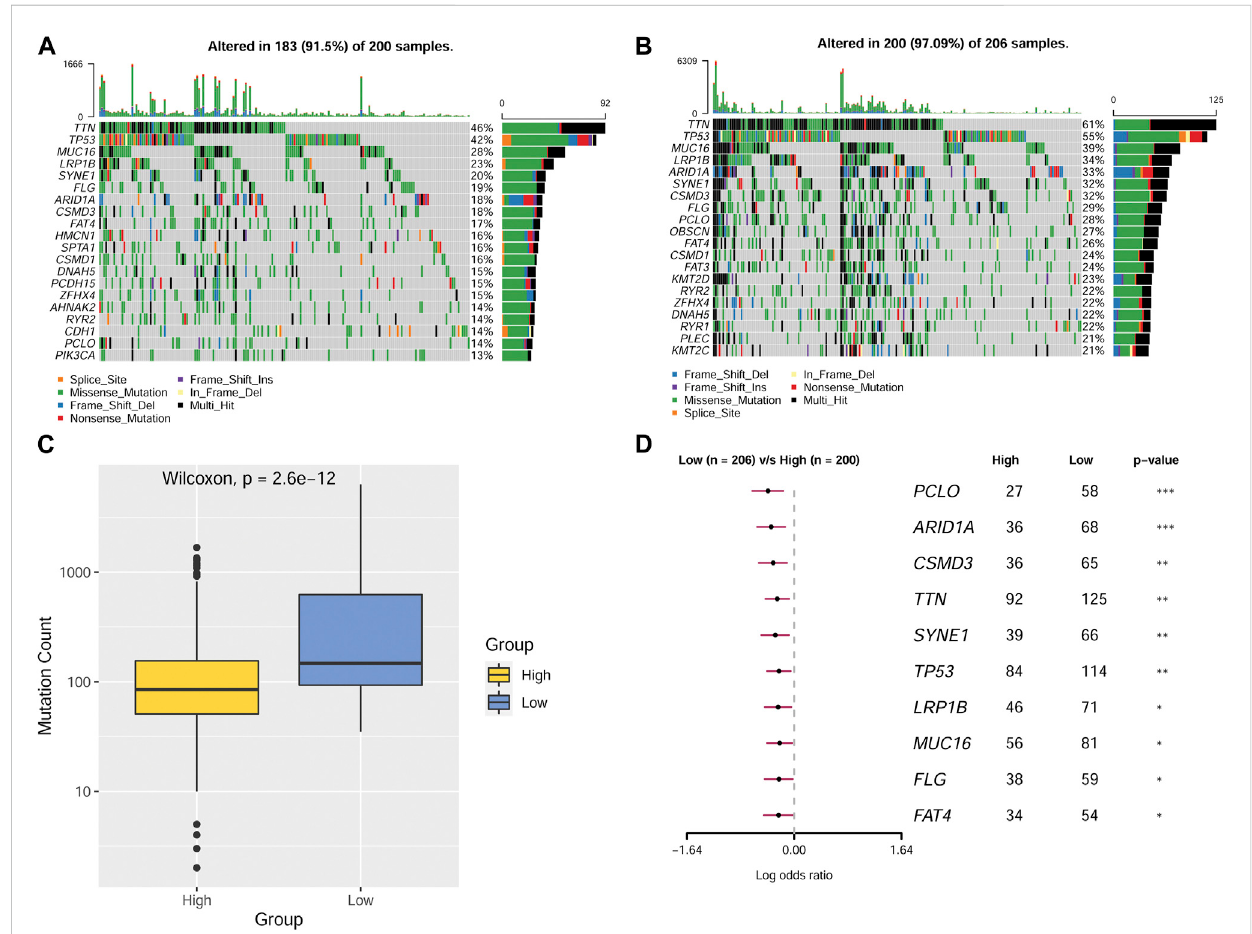
FIGURE 6 Mutations in patients from different MMP scoring groups (A) Mutations in MMP high-scoring group. (B) Mutations in MMP low-scoring group. (C) Mutation counts in different MMP scoring groups. (D) Forest plot depicting statistical differences of various genes in different MMP scoring